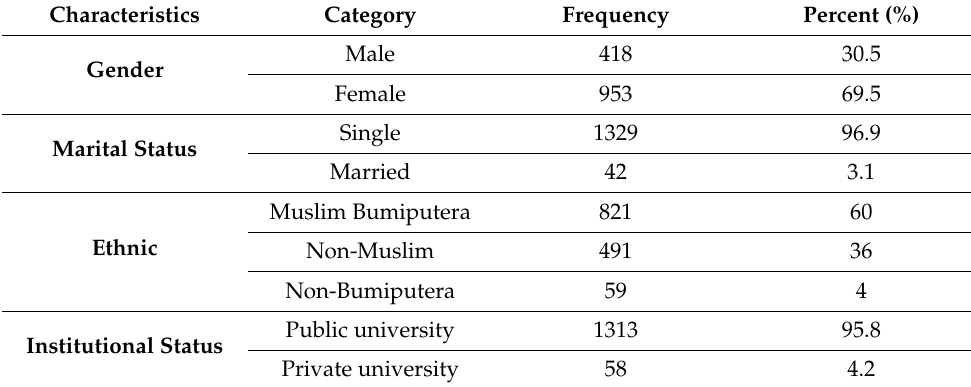
Table 2. Demographic profile of respondents.